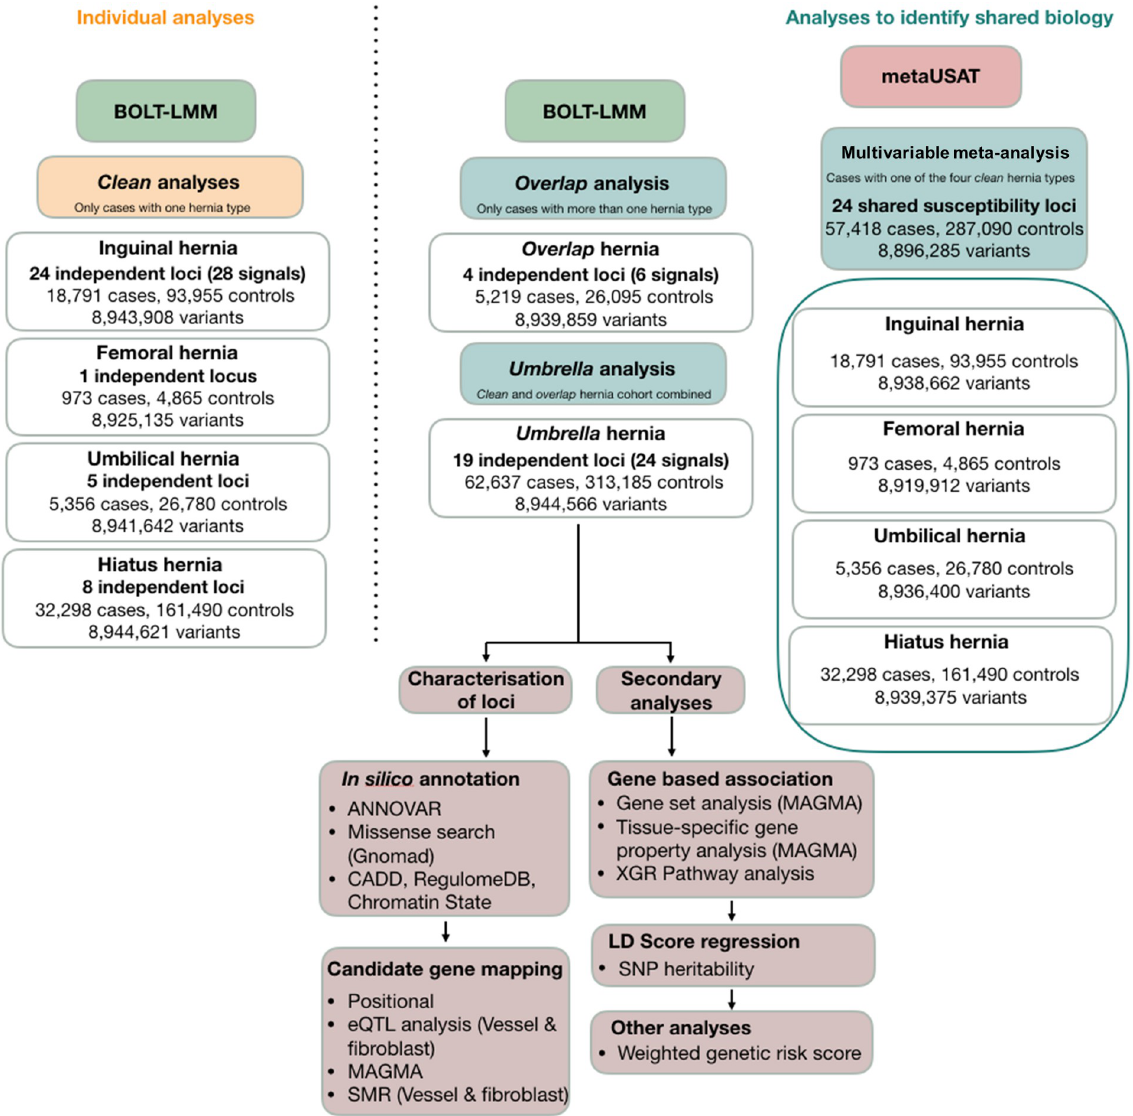
Fig 2. Study design and shared genetics analysis workflow. The three analysis approaches to characterise the shared genetic underpinnings of the ‘hernia phenotype’ are depicted.